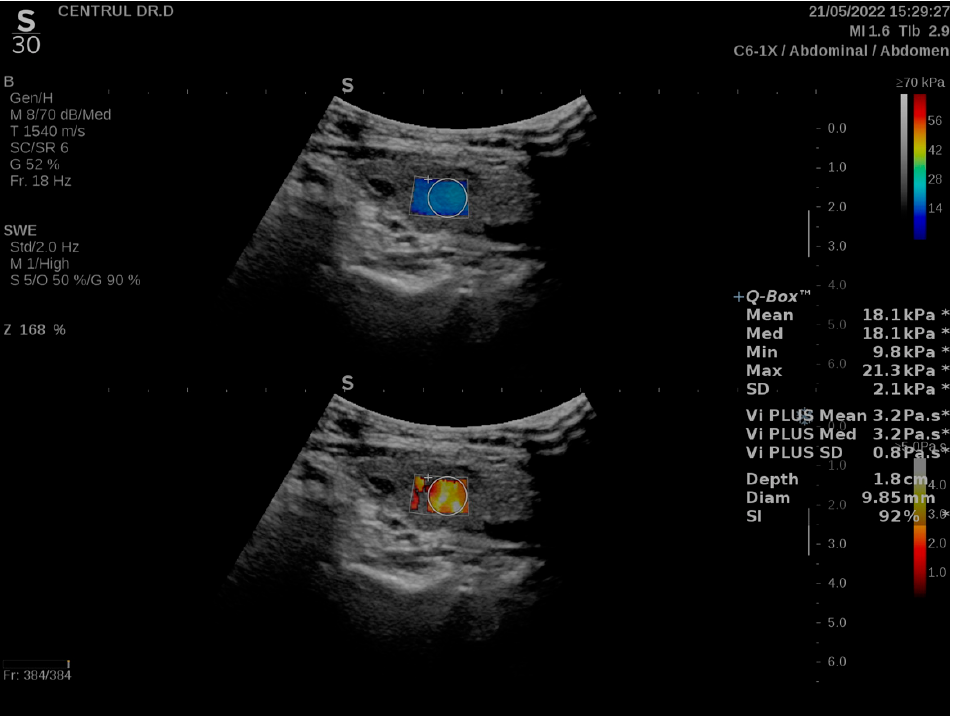
Figure 1. Shear-wave color map (above) and viscosity map (below) overlayed on the greyscale ultrasound image in a case of chronic autoimmune thyroiditis; shear-wave values (mean, median, minimum maximum and standard deviation estimated in kPa), viscosity values (mean, median and standard deviation estimated in Pa · s) and characteristics of the region of interest (depth in cm, diameter in mm and stability index in percentage) are displayed on the right side of the image; the SWE-based parameters are marked with